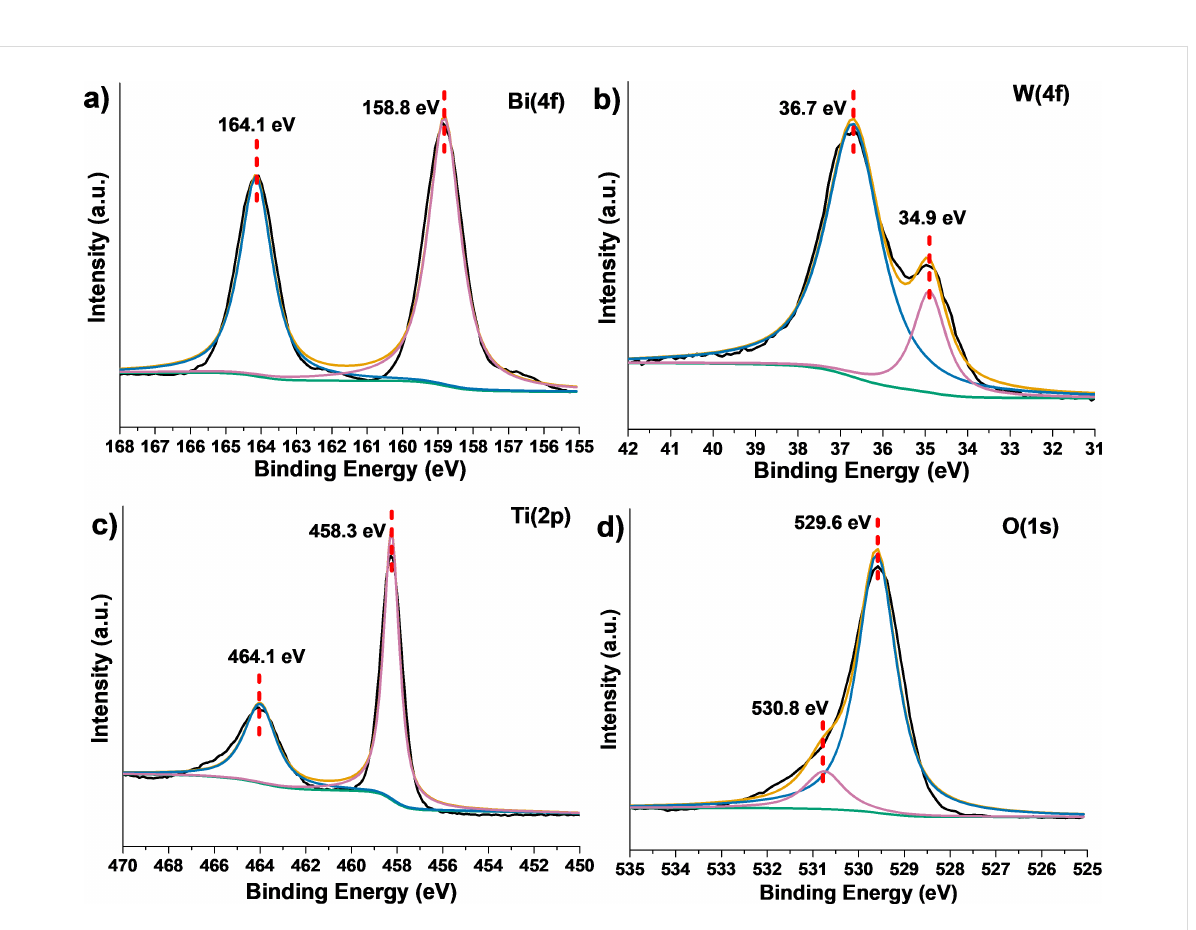
Figure 5: High-resolution XPS spectra of the (a) Bi 4f, (b) W 4f, (c) Ti 2p, and (d) O 1s regions of the hierarchical 70% − Bi 2 WO 6 /TiO 2 -NT nanocom-